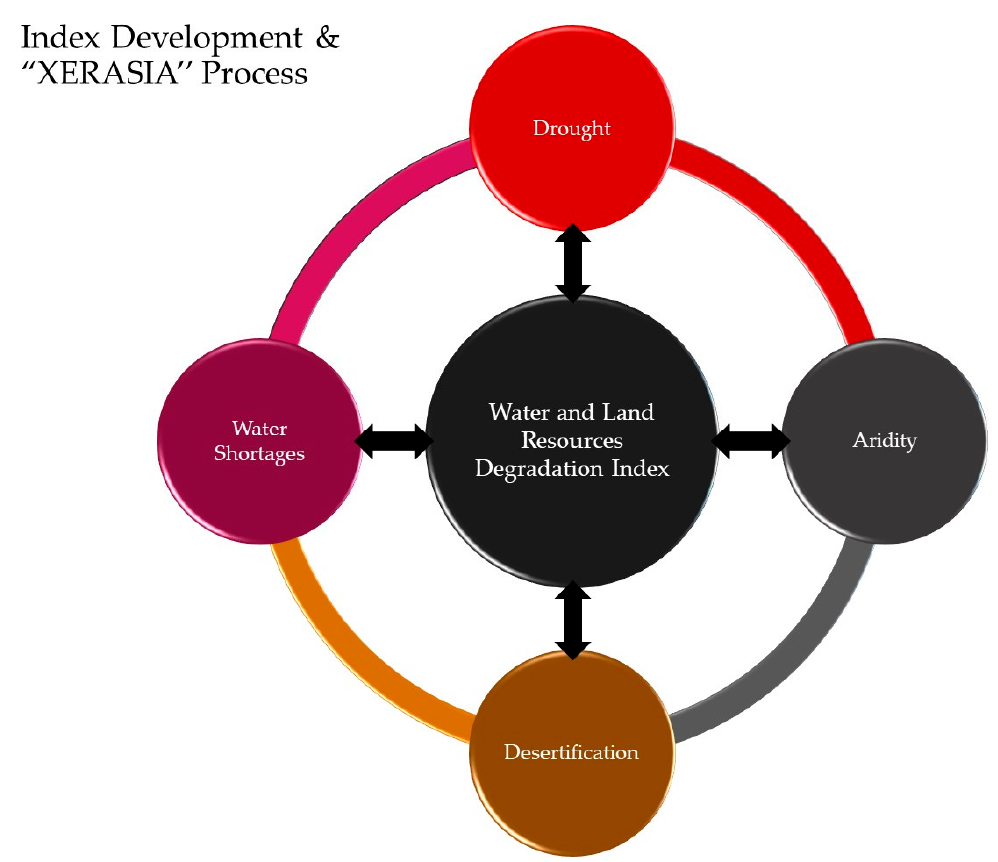
Figure 1. Main scheme of the XERASIA process and the WLDI [22,23,57].